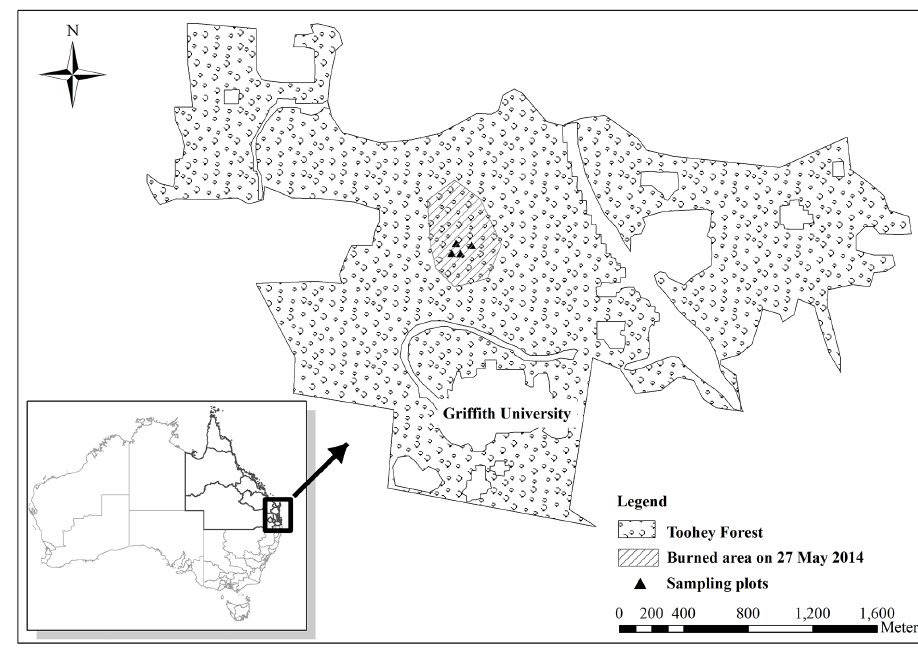
Figure 1. Map of the study site in Toohey Forest located in south-eastern Queensland, Australia. Table 1. Weather conditions for the three sampling events, precipitation was recorded by the M t Gravatt Alert weather station (27.55 ◦ S, 153.07 ◦ E, ∼ 2km from the sampling plots) and the data were collected at the website of Bureau of Meteorology (http://www.bom.gov.au). Sampling Sampling Antecedent Antecedent Rainfall during Temperature events dates precipitation a precipitation sampling measured (30 days, mm) (3months, mm) period on-site Aug 2013 27–30 4 71 Aug 2014